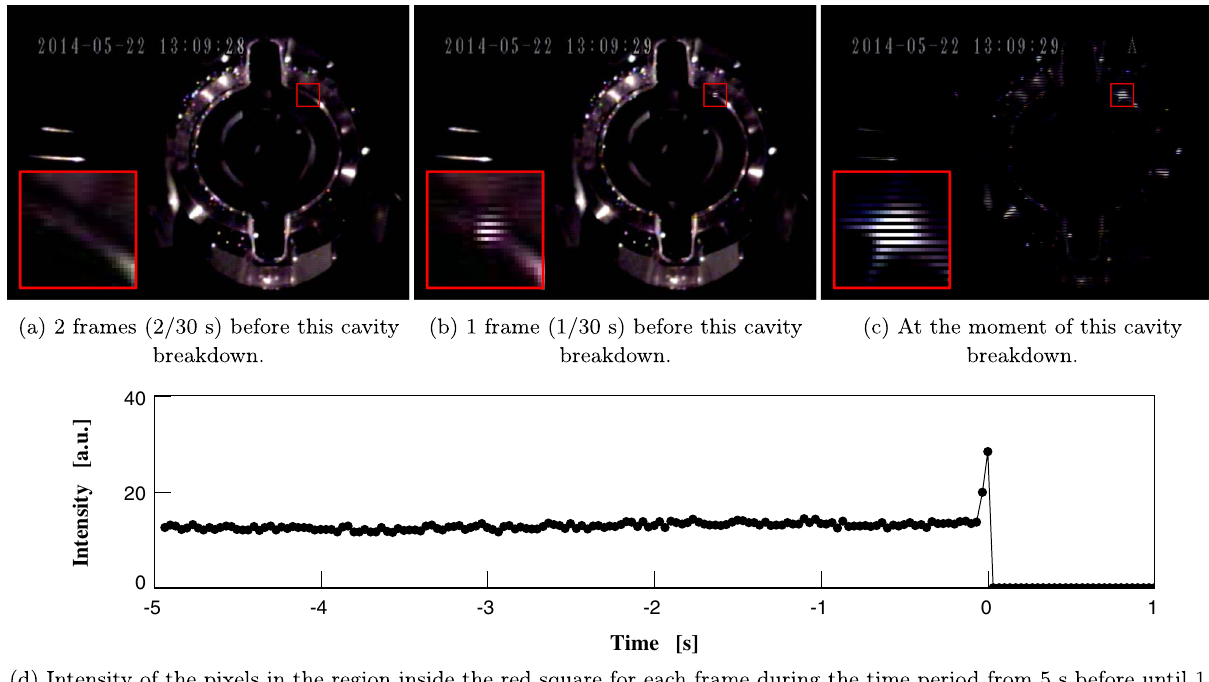
FIG. 13. Example of spot-type explosion events without a stable bright spot, accompanied by the sudden appearance of a new bright spot. (a), (b), and (c) are snapshots, in chronological order, of the FEP recorded with TV camera 3 during the rf conditioning. The insets are magnified views of the region outlined by a red square. There was an explosion at 1 o ’ clock [inside the red squares in (b) and (c)] at V ¼ 0 . 56 MV; however, no bright spot was present in this region until 2 frames ( 2 = 30 s) before this cavity breakdown, as indicated by c the red square in (a). A clear spike was observed in the intensity of the region outlined by a red square at the moment of this cavity breakdown for two frames, as shown in (d).